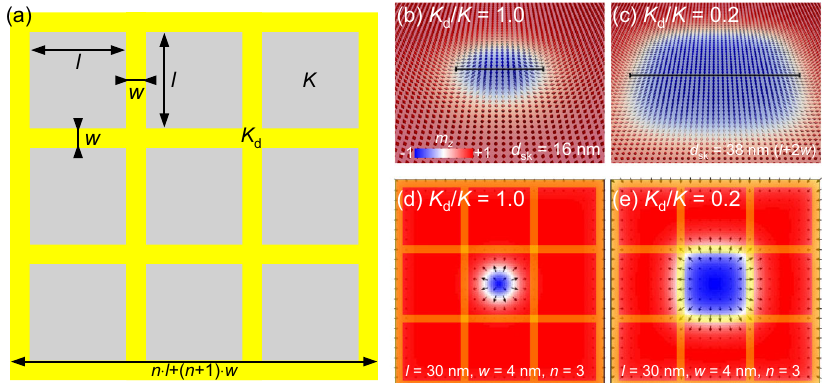
Fig. 1 An ordinary magnetic skyrmion and a square-shaped magnetic skyrmion. a Top-view schematic of the simulation geometry. l denotes the spacing between two adjacent parallel defect lines. w denotes the width of the defect line. n denotes the number of unit square patterns along the x and y directions. The total side length of the ferromagnetic layer equals n ⋅ l + ( n + 1) ⋅ w . K and K d stand for the perpendicular magnetic anisotropy constants for the unmodi fi ed areas and defect lines, respectively. The defect lines with reduced K d are indicated by yellow lines. The thickness of the ferromagnetic layer is fi xed at 1 nm. b Illustration of a relaxed ordinary round-shaped skyrmion with the topological charge of Q = 1 at the center of a sample with K side length of the sample equals 106 nm. The relaxed skyrmion diameter d sk equals 16 nm, which is indicated by the black line. The color scale represents the out-of-plane magnetization component m z , which has been used throughout the work. c Illustration of a relaxed square-shaped skyrmion with Q = 1 at the center of a sample with K d / K = 0.2. Here, l = 30 nm, w = 4 nm, and n = 3. The side length of the sample equals 106 nm. The relaxed skyrmion diameter d sk equals 38 nm, as indicated by the black line. d Top view of the sample with corresponding to ( c